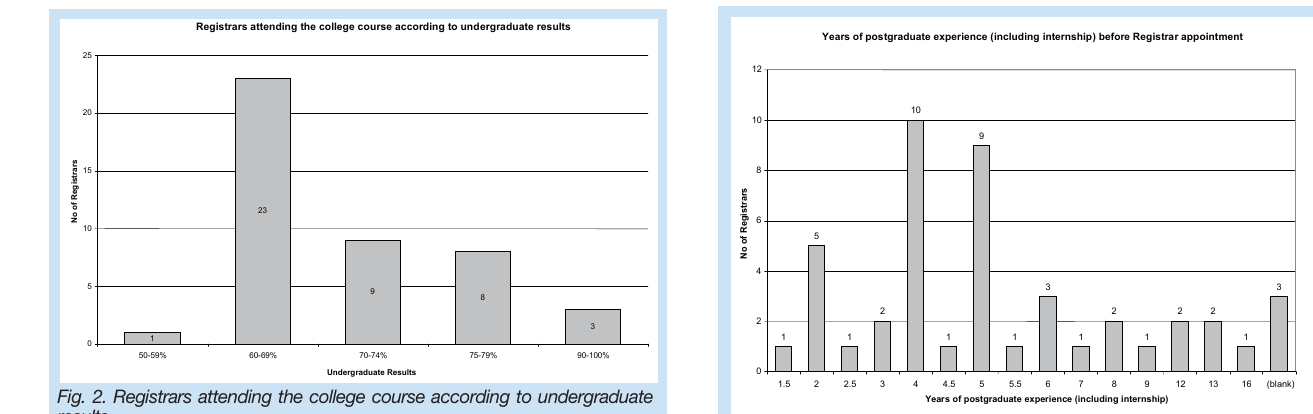
Fig.2.Registrarsattendingthecollegecourseaccordingtoundergraduateresults.